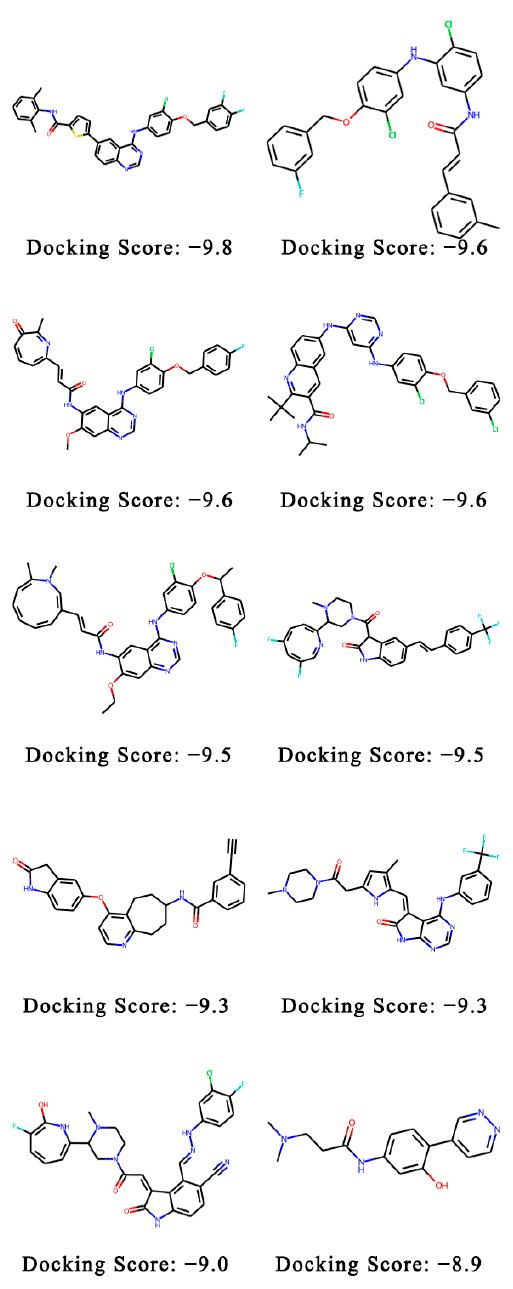
Figure 1. Examples of molecules generated with PETrans against EGFR. Of the molecules generated, those with the best QuickVina-W scores were shown. The colored sections represent different groups.